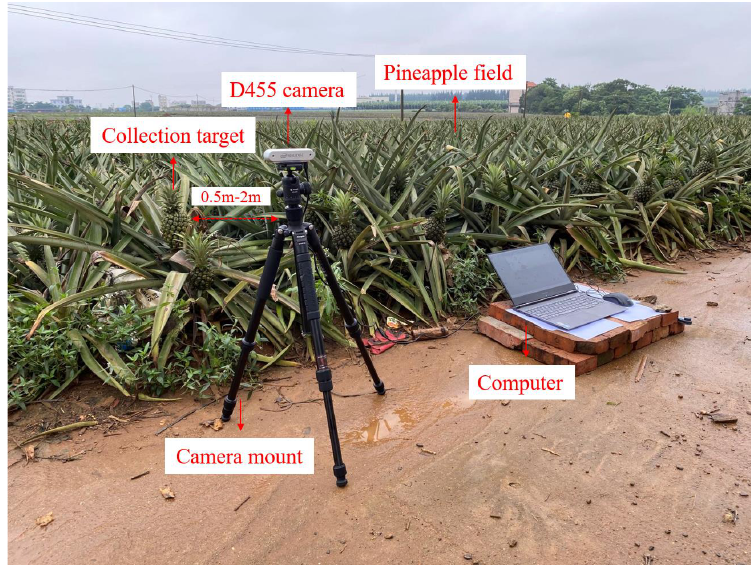
Figure 1. Image acquisition equipment.